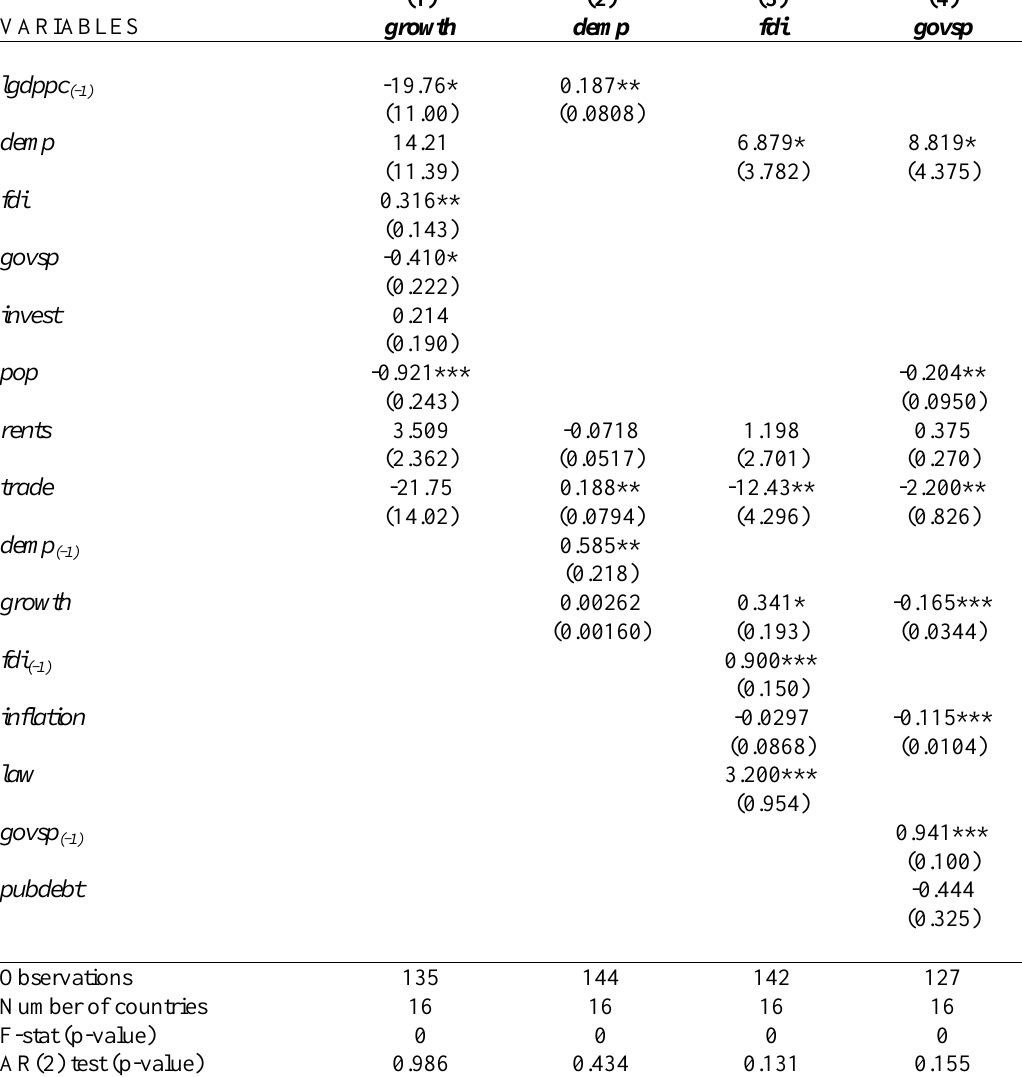
Table A5: Robustness checks: Alternative measure of